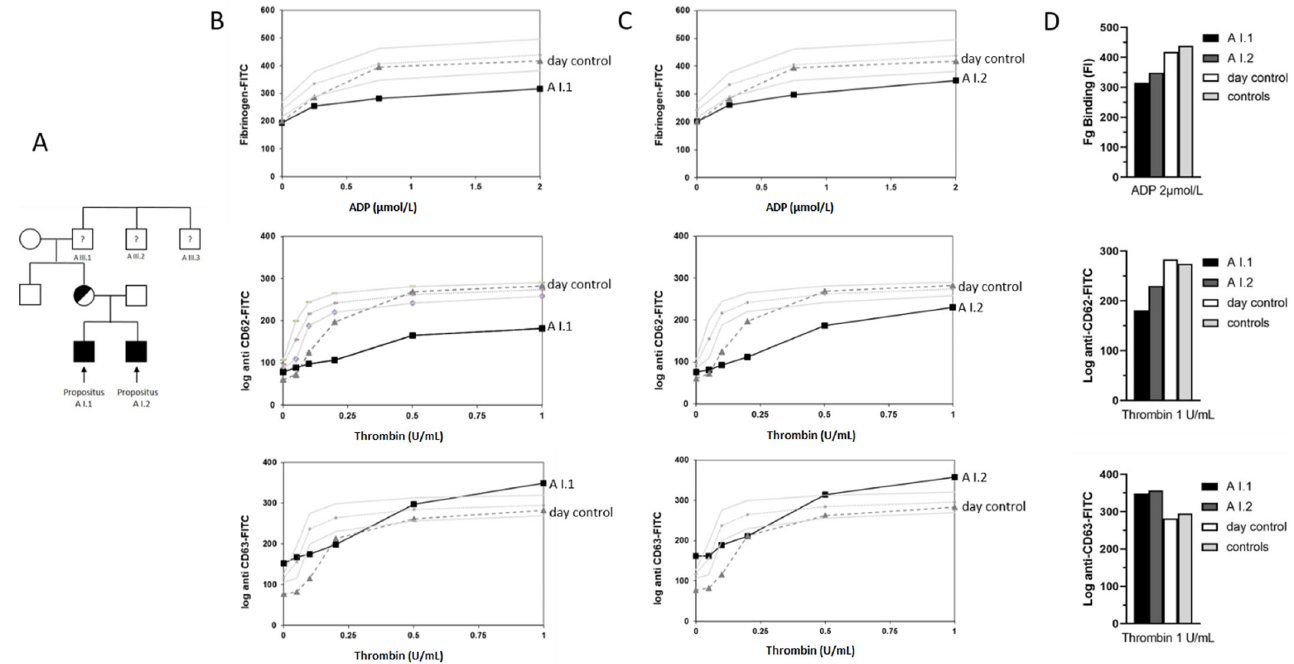
Figure 3. Family tree and platelet phenotyping in the German pedigree A. ( A ) Genetic pedigree of family A. Solid black symbols represent affected family members carrying the hemizygous GATA1 p.D218N variant; black–white circles represent heterozygous female carriers of the variant. Question mark represents male family members with reported phenotype without clinical or genetic data available. Flow cytometry for A I.1 ( B ) and for his younger brother A I.2 ( C ): both patients showed decreased fibrinogen binding (upper panel), severely reduced CD62 expression (middle panel), and slightly higher CD63 expression values after stimulation with high concentration of thrombin (lower panel) compared to healthy day control/controls (20 independent measurements from 10 controls as mean ± standard error of the mean (SEM)). ( D ) Bars correspond to fluorescence intensity (FI) values (log) at the highest concentration of the used